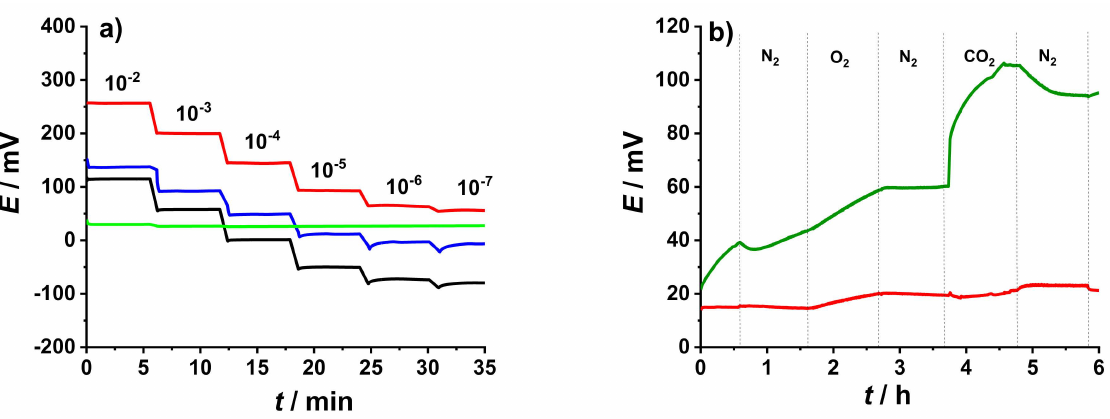
Figure 3. ( a ) Comparison between the potentiometric response of different K + - ISEs: GC/PEDOT:PSS/ 50 µ L K + - ISM (black line), GC/MWCNTs/50 µ L K + - ISM (red line), and conventional K + - ISE (blue line), and GC/10 mC PEDOT:PSS/25 µ L DM (green line) in 10 − 2 M to 10 − 7 M KCl solution with 10 − 1 M NaCl as BGE. ( b ) Gas sensitivity of electrodes: GC/10 mC PEDOT:PSS (green line) and GC/10 mC PEDOT:PSS/25 µ L DM (red line) carried out in 10 − 3 M KCl